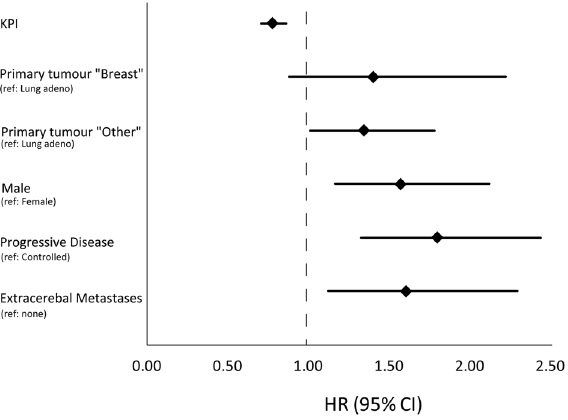
Figure 2. Multivariate analysis of significant prognostic factors for